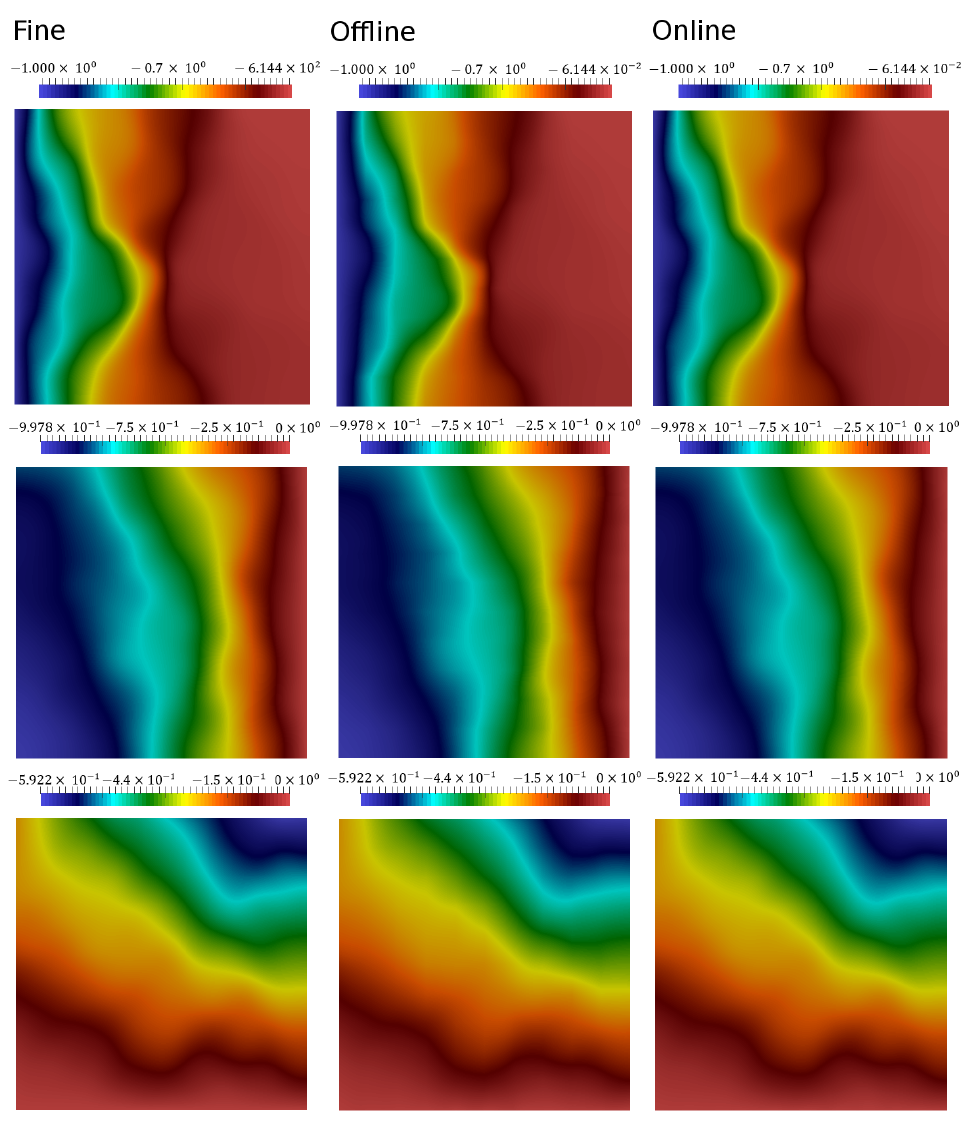
Figure 9. Case 1 . Fine-scale solution with DOF h = 12,944 ( left ), coarse-scale using 2 offline basis functions with DOF H = 726 ( middle ), and coarse-scale with one online residual-based multiscale basis function with DOF H = 1089 ( right ) at the final time. ( Top ) Pressure. ( Center ) Displacement X direction. ( Bottom ) Displacement Y